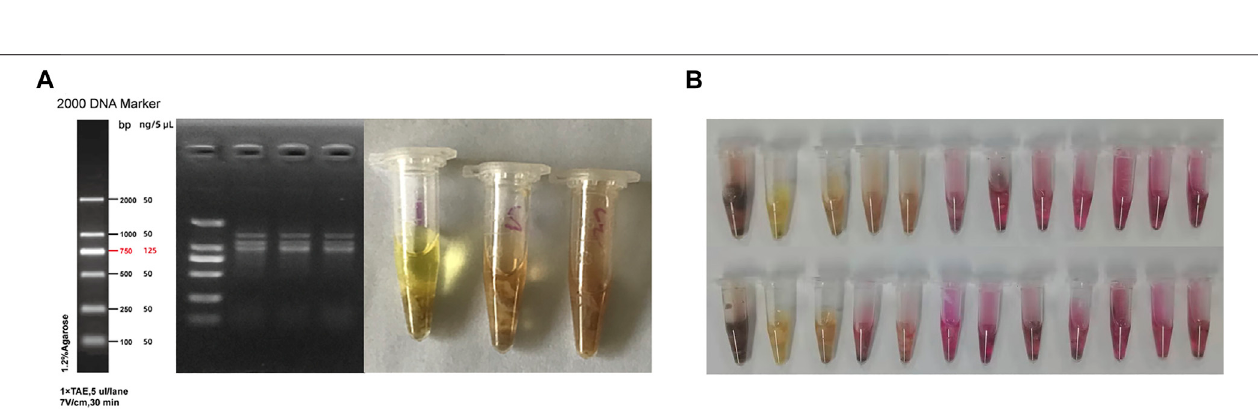
FIGURE 1 | Effect of Hp-associated chronic gastritis on weight in mice. (A) Split violin plot showing the effect of Hp-associated chronic gastritis on weight at the beginning; (B) Split violin plot showing the effect of Hp-associated chronic gastritis on weight at the end.